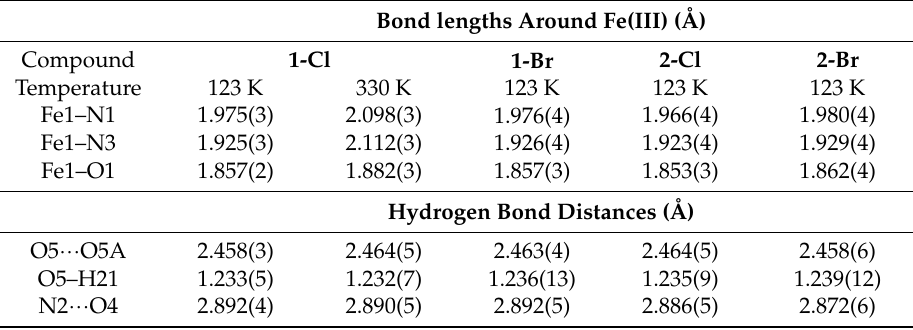
Table 2. Coordination and hydrogen bond distances in 1-Cl , 1-Br , 2-Cl , and 2-Br . Bond lengths Around Fe(III) (Å)